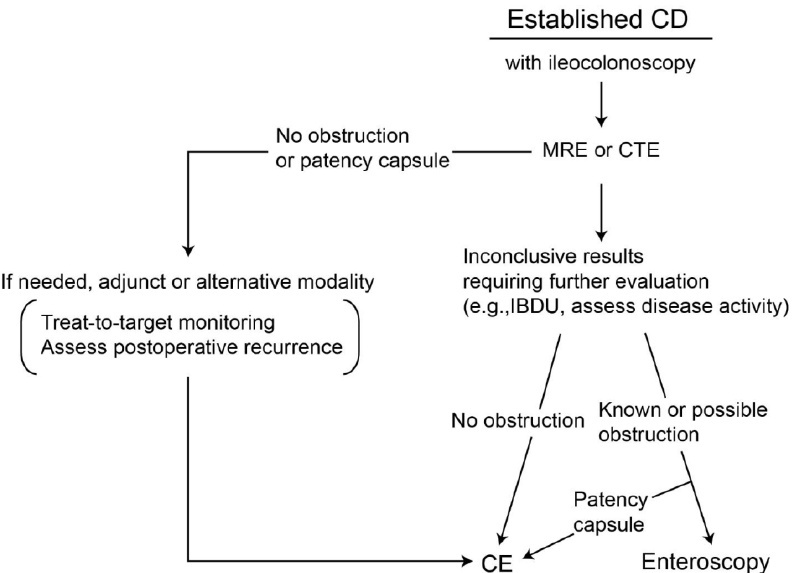
Figure 3. Suggested diagnostic algorithm for the use of small bowel capsule endoscopy in patients with established Crohn’s disease. CD, Crohn’s disease; MRE, MR enterography; CTE, CT enterography; IBDU, unspecified inflammatory bowel disease; CE, capsule endoscopy.